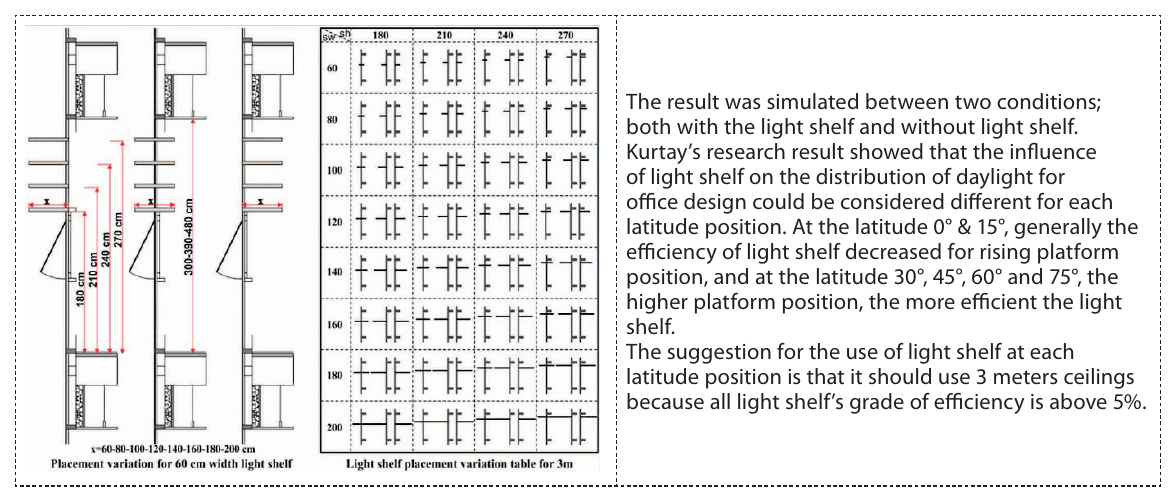
Fig. 9. Variation of light shelf width and position Source: Kurtay, Esen 2016.